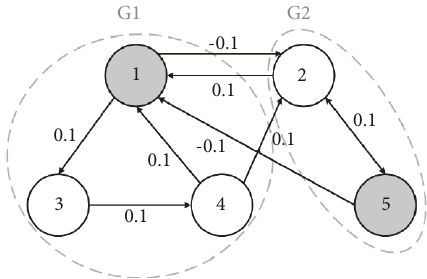
Figure 5: The directed graph topology of the heterogeneous MASs.